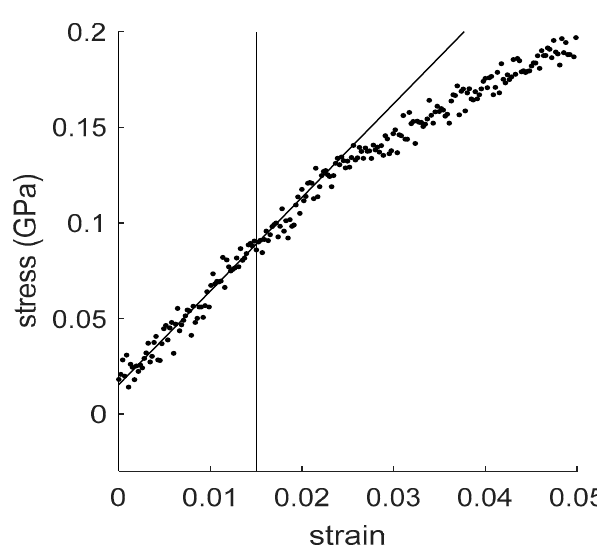
Figure 5. Typical stress–strain curve of xylan in tension obtained by strain loading at 15% moisture content. The vertical line indicates the end of the linear regime. The slope of the linear regime is taken as the bulk modulus in tension.